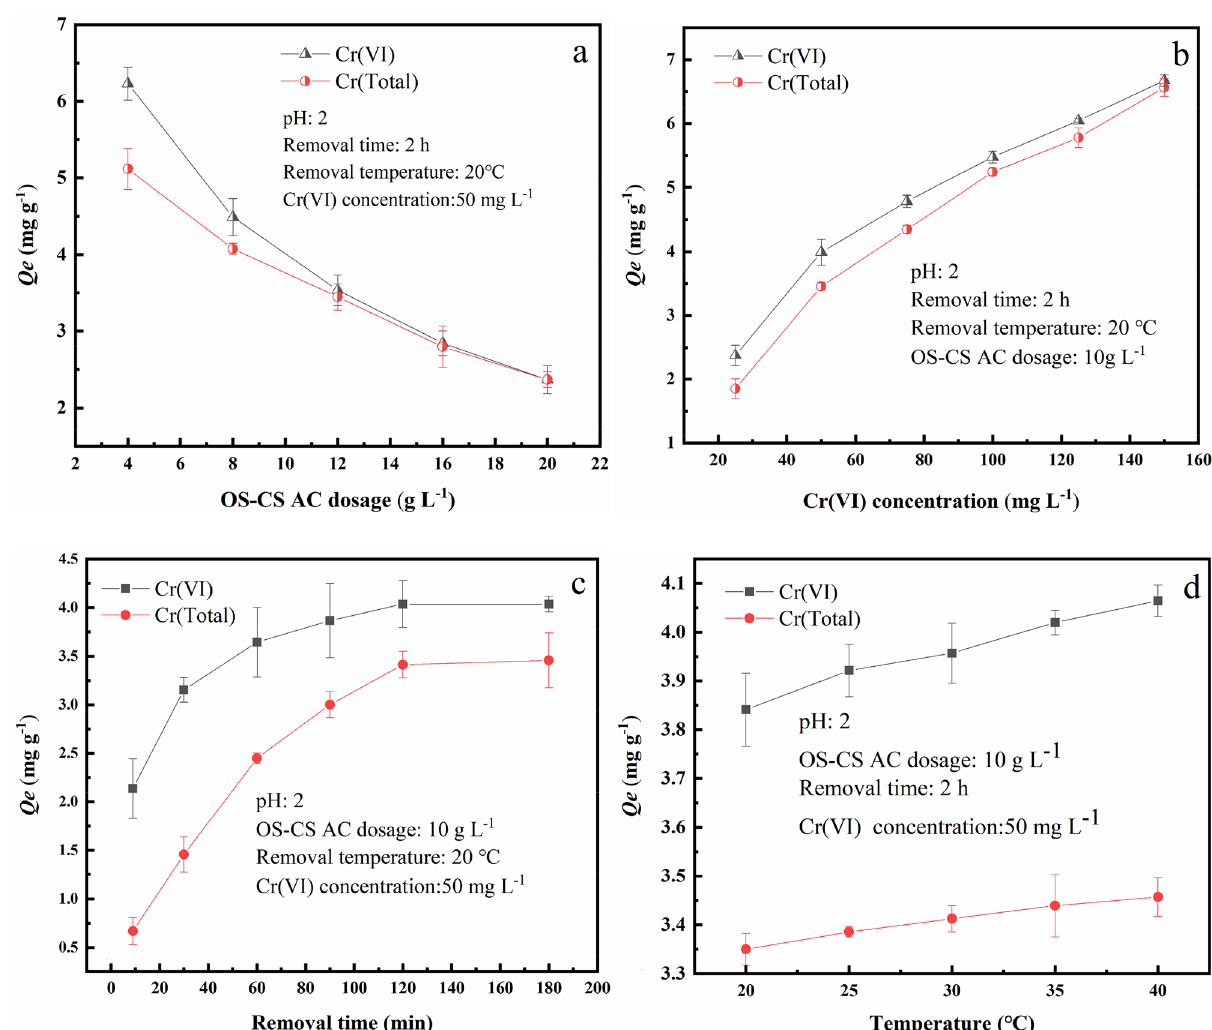
Figure 2. The influence of OS-CS AC dosages on Cr(VI) and Cr(Total) removal ( a ), The influence of the initial concentration of Cr(VI) on the removal of Cr (VI) and Cr (Total) ( b ),The influence of removal time on